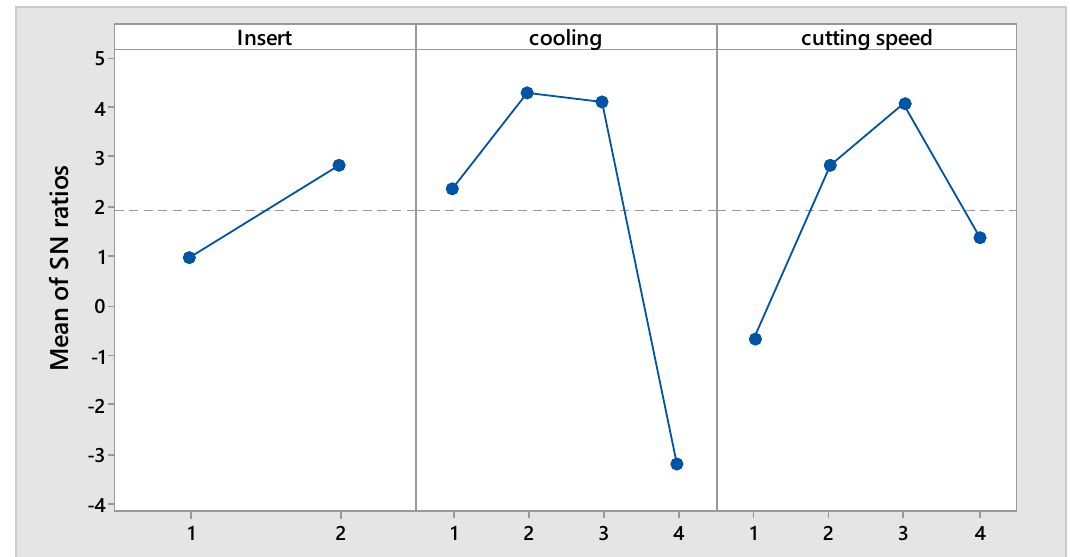
Figure 6. S/N ratios of R Figure 6: S / N ratios of R a for machinability parameters.